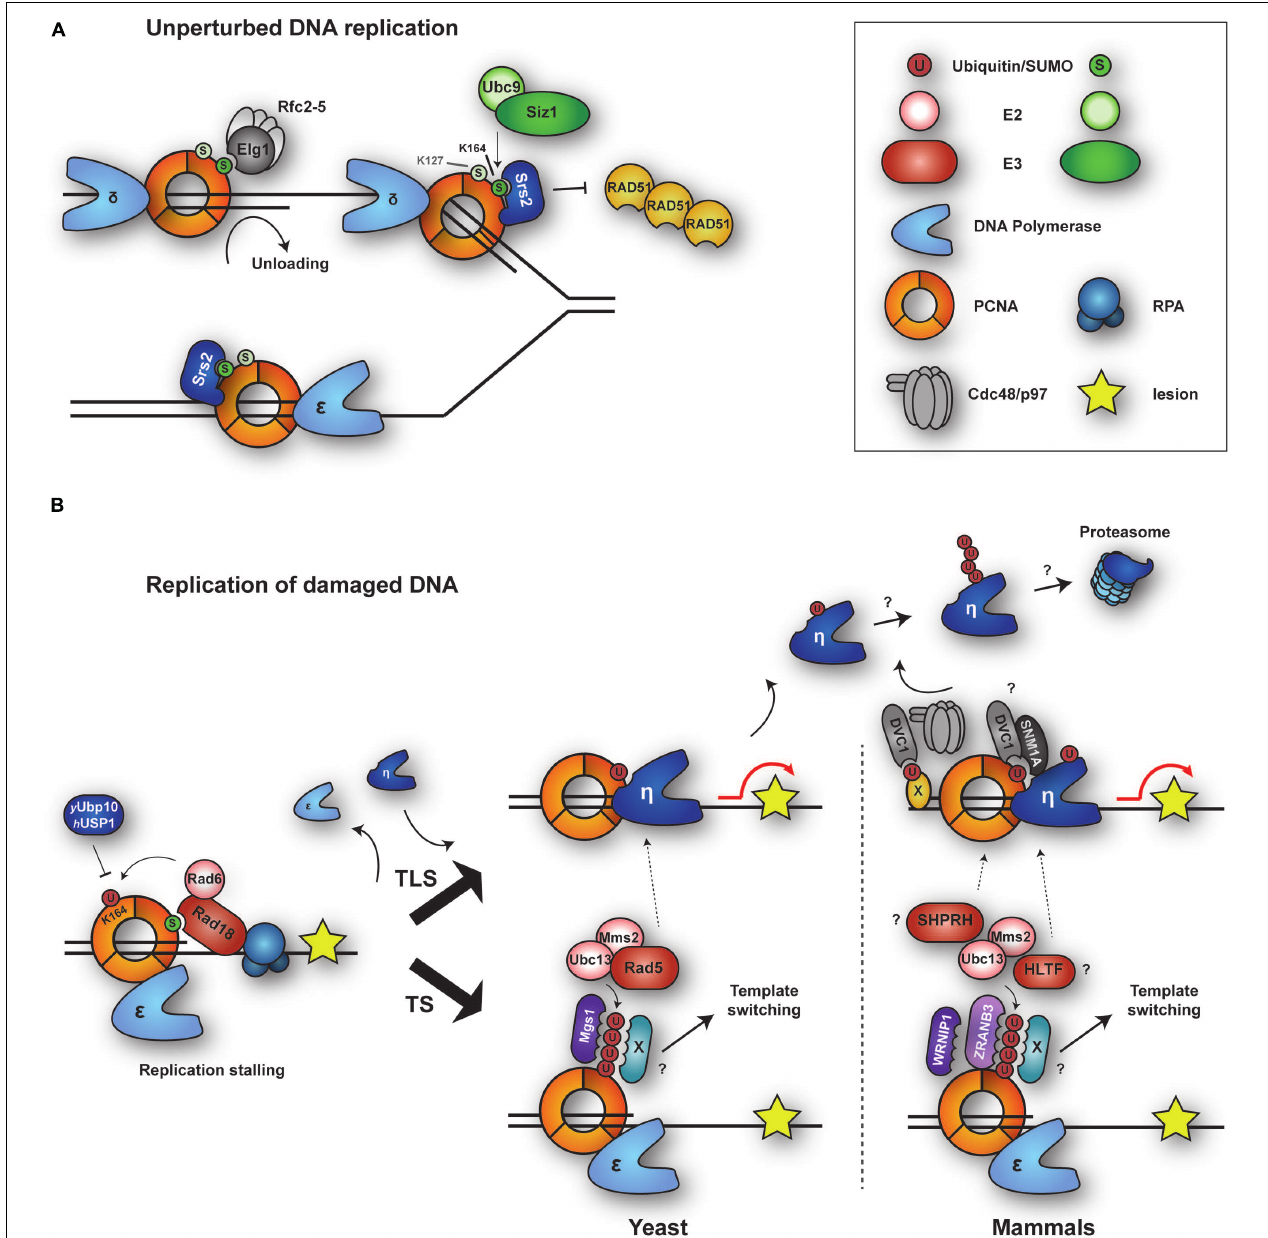
FIGURE 1 | Modifications of PCNA by ubiquitin and SUMO during replication of intact and damaged DNA. (A) During unperturbed replication, budding yeast PCNA is SUMOylated at K164 and to a minor extent at K127. Modification at K164 is mediated by SUMO E2-E3 Ubc9-Siz1. PCNA SUMO recruits anti-recombinogenic helicase Srs2 to counteract Rad51 filament formation. RFC-like complex RLC-Elg1 interacts with PCNA SUMO and unloads PCNA from DNA. (B) Upon replication stalling and exposure of ssDNA, E2-E3 complex Rad6-Rad18 is recruited by interaction with the RPA complex and (in yeast) SUMO and monoubiquitylates PCNA at K164. This modification is removed by Ubp10 (yeast) or USP1 (humans). Monoubiquitylated PCNA recruits damage-tolerant DNA polymerases for translesion synthesis (TLS), while polyubiquitylated PCNA initiates template switching (TS) by a poorly defined mechanism. Auxiliary factors